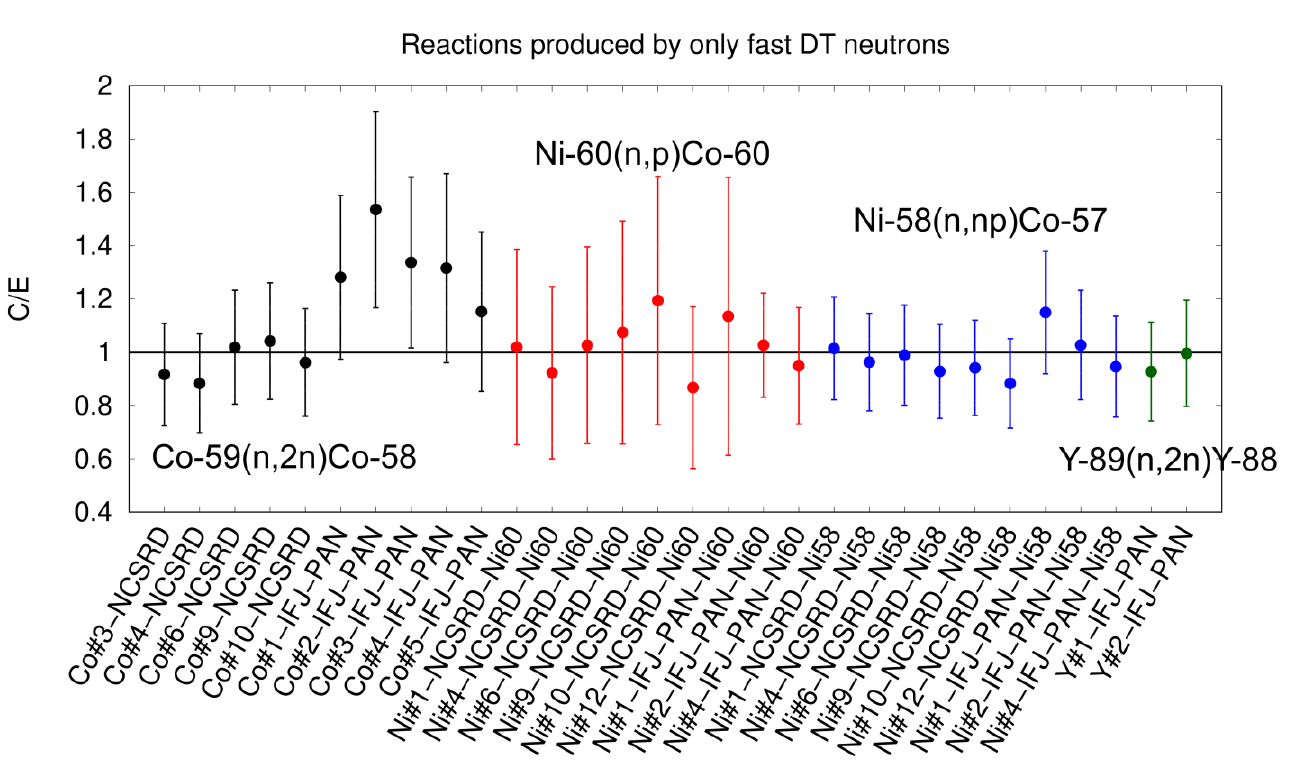
Fig. 6 Comparison of the calculated activity with measured for isotopes in dosimetry foils produced by fast neutrons - Co-59(n,2n)Co-58, Ni- 60(n,p)Co-60, Ni-58(n,np)Co-57 and Y-89(n,2n)Y-88. The DT neutron fraction used in the analysis was 1.4 %. The error bars represent 2 sigma statistical uncertainty of MCNP calculations and uncertainty in measured sample activity. The number next to the material name represents the ID of the